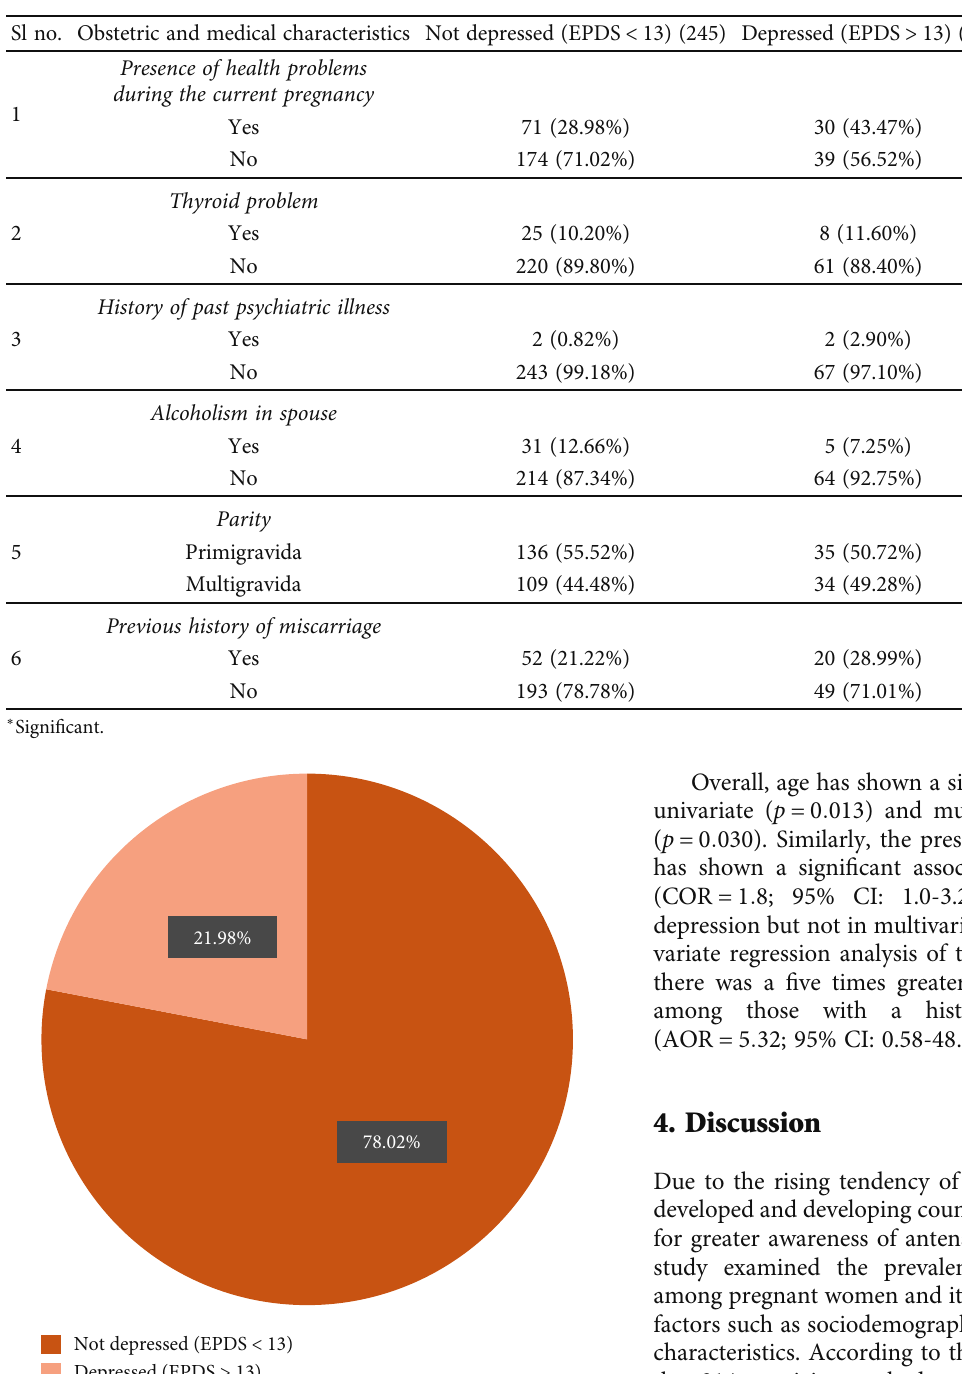
Table 2: Obstetric and medical characteristics of the study